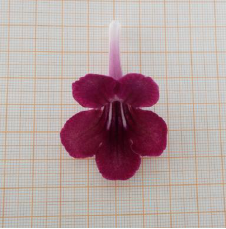
Figure 2. ”Bristol’s Gum Drop” variety. Figure 2. “Bristol’s Gum Drop”